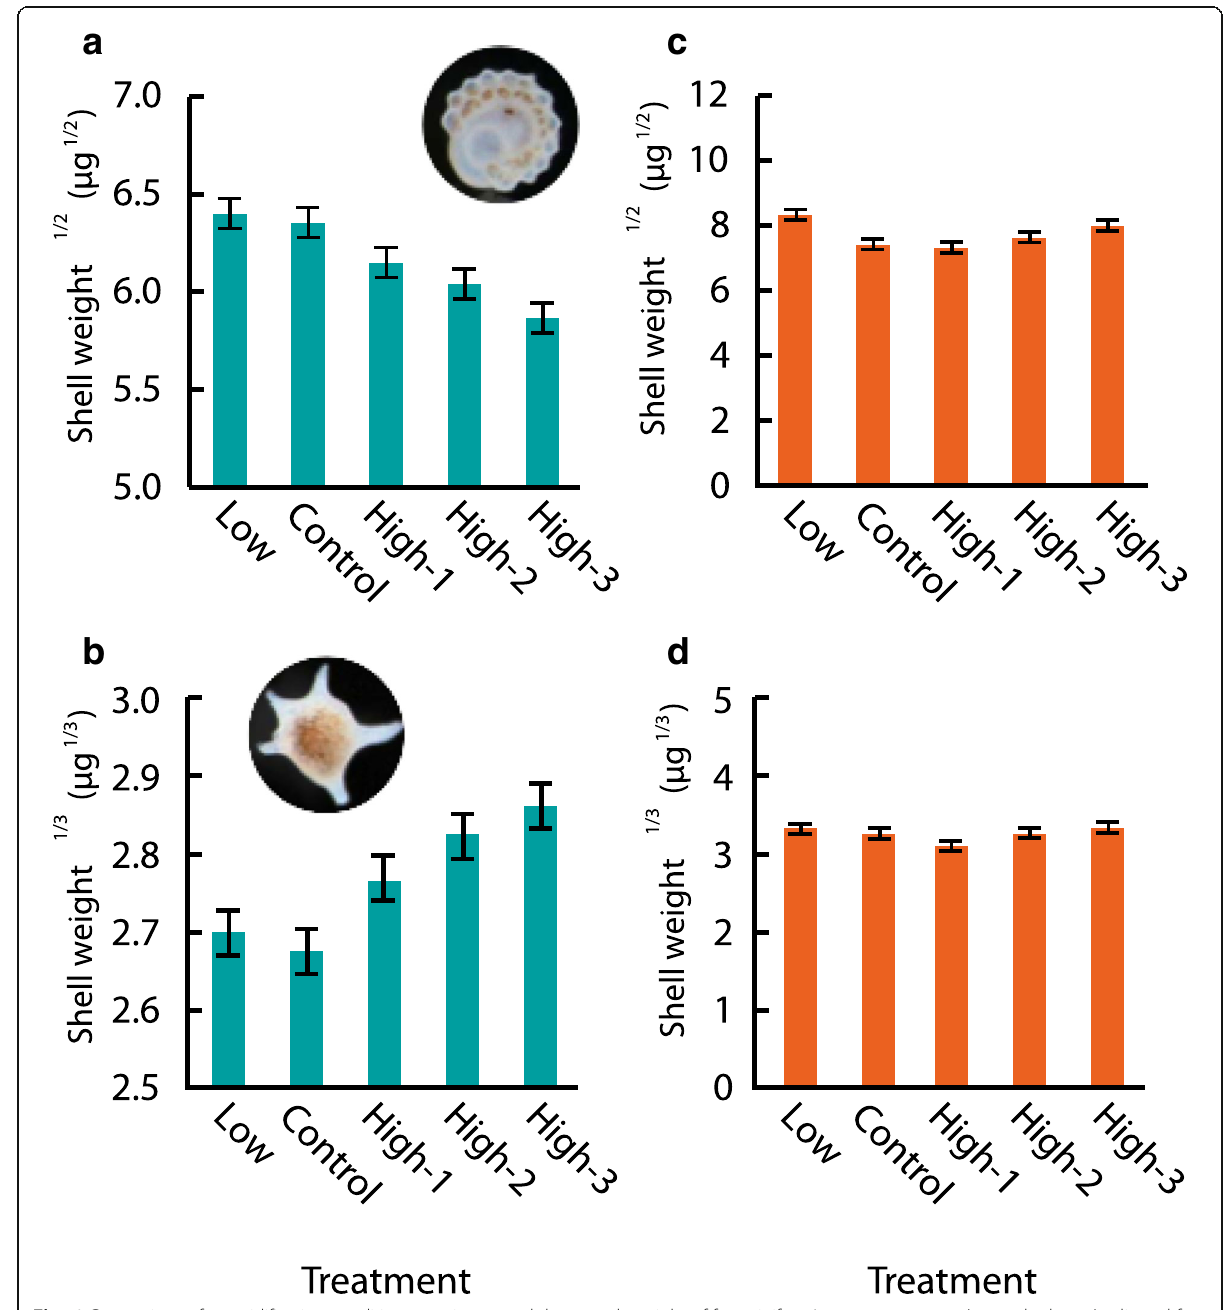
Fig. 6 Comparison of an acidification condition experiment and the growth weight of foraminifera. Least mean square (±standard error) adjusted for the rearing tank of ( a ) the square root of the shell weight of A . kudakajimensis and ( b ) the cube root of the shell weight of C . gaudichaudii after the ocean acidification experiment (Hikami et al. 2011). In this experiment, foraminifera were cultured under five different p CO 2 conditions, 245 (Low- [ p CO 2 ], comparable to pre-industrial condition), 375 (Control-[ p CO 2 ], comparable to modern condition), 588 (High-1-[ p CO 2 ]), 763 (High-2-[ p CO 2 ]), and 907 (High-3-[ p CO 2 ]) μ atm, maintained with a precise p CO 2 -controlling technique. Arithmetic mean (±standard error) of ( c ) the square root of the shell weight of A . hemprichii and ( d ) the cube root of the shell weight of C . gaudichaudii after a constant carbonate ion ([CO 3 − 2 =217 – 218 μ mol kg − 1